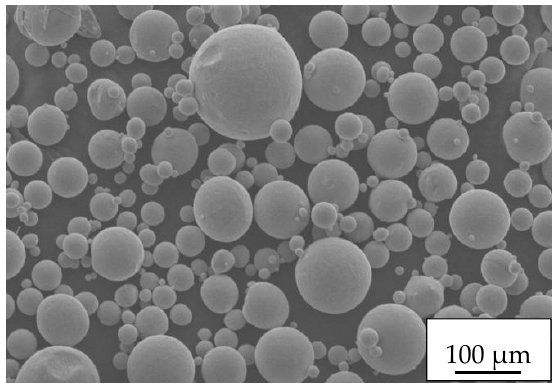
Figure 1. SEM of CoCr alloy powder particles. Table 2. The selective laser melting (SLM) test scheme.